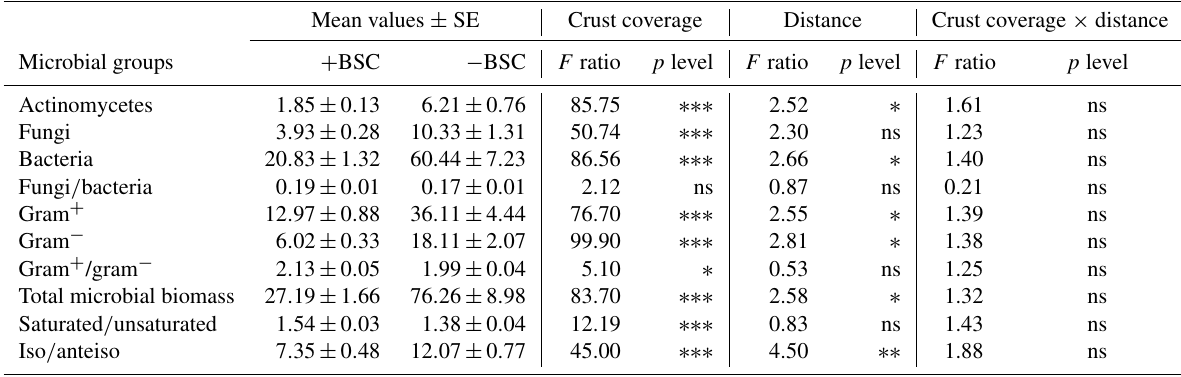
Table 1. Effect of the crust presence or absence (“Crust coverage”), distance (0, 20, 40, 60, 80 and 100cm), and their interaction (“Coverage × distance”) on the biomass of various microbial groups. The asterisk indicates the level of significance ( ∗ : p < 0 . 05; ∗∗ : p < 0 . 01; ∗∗∗ : p < 0 . 001; and ns: not statistically significant). All microbial groups are expressed in nanomoles per gram.